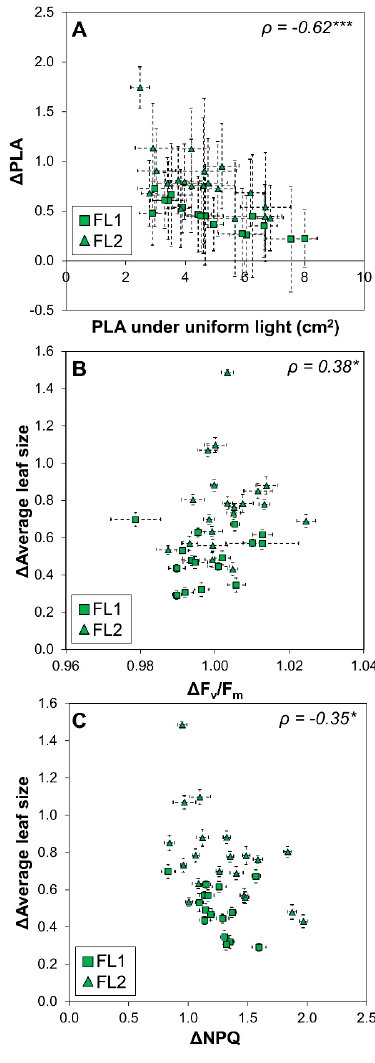
Figure 7. Changes in growth and chlorophyll a fluorescence in 36 Arabidopsis accessions grown under fluctuating compared to uniform light. ( A ) Relationship between projected leaf area (PLA) under uniform light and the response ratio of PLA under fluctuating light divided by PLA under uniform light ( Δ = FL/U), ( B ) relationship between the response ratio of average leaf size and the response ratio of photosystem II maximum quantum efficiency ( Δ F v /F m ), and ( C ) relationship between the response ratio of average leaf size and the response ratio of non-photochemical quenching ( Δ NPQ). Data are sorted by FL experiment 1 (squares) and FL experiment 2 (triangles). Averages ± SE (n = 5–7). Spearman’s ρ and the significance of a linear correlation through all points is shown (*** = p <0.001, * = p < 0.05).